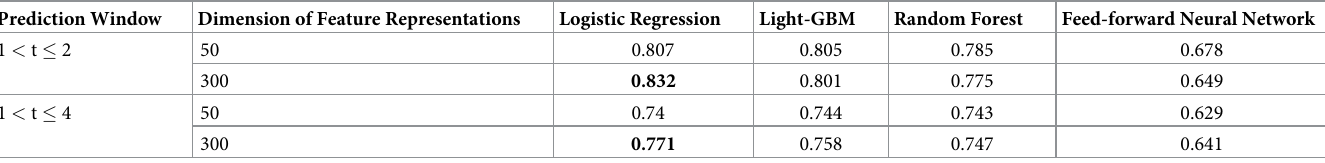
The columns show the comparison among the models, and the rows show the comparison among two variants of dimensions in FastText features. The bold numbers indicate the highest AU-ROC scores and the best performing models for both short-term prediction windows.